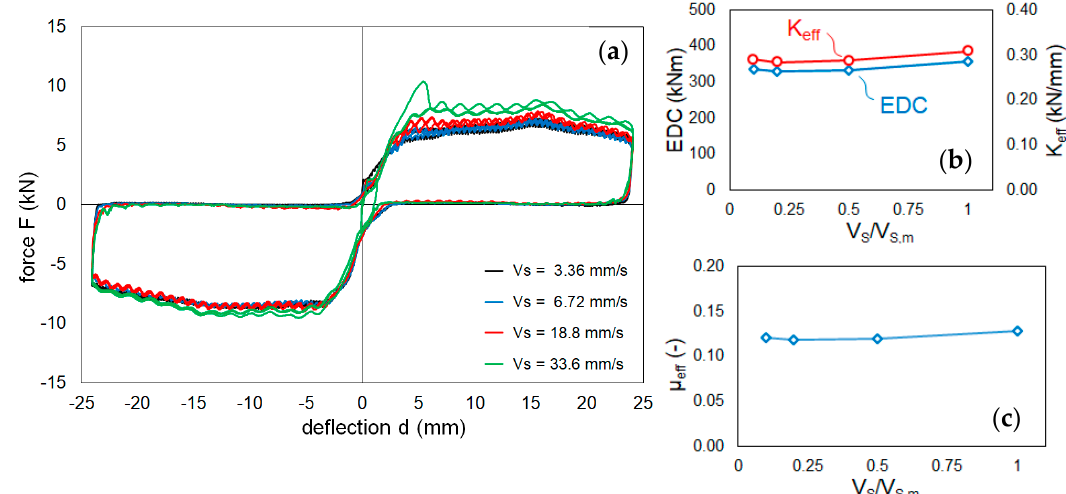
Figure 11. Dynamic test D1: ( a ) horizontal force–deflection diagrams at different velocities V S ; ( b ) influence of the velocity on effective stiffness K eff , energy dissipated per cycle EDC; ( c ) effective coefficient of friction μ eff . V S,m is the maximum test velocity.